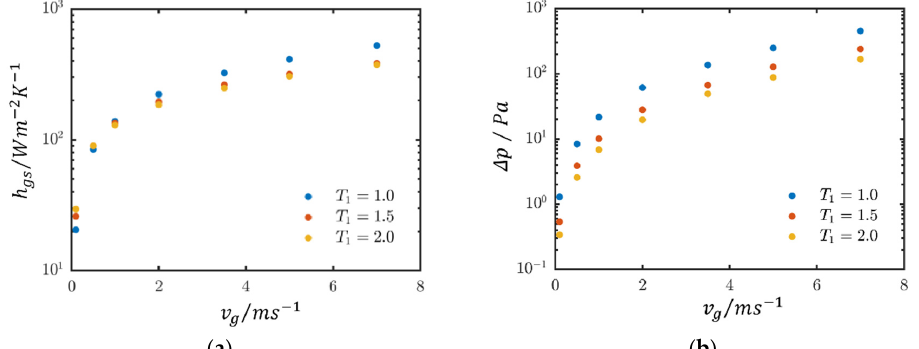
Figure 8. Variation of heat transfer coefficient ( a ) and pressure loss ( b ) as function of inflow velocity and dimensionless warp wire pitch T 1 .